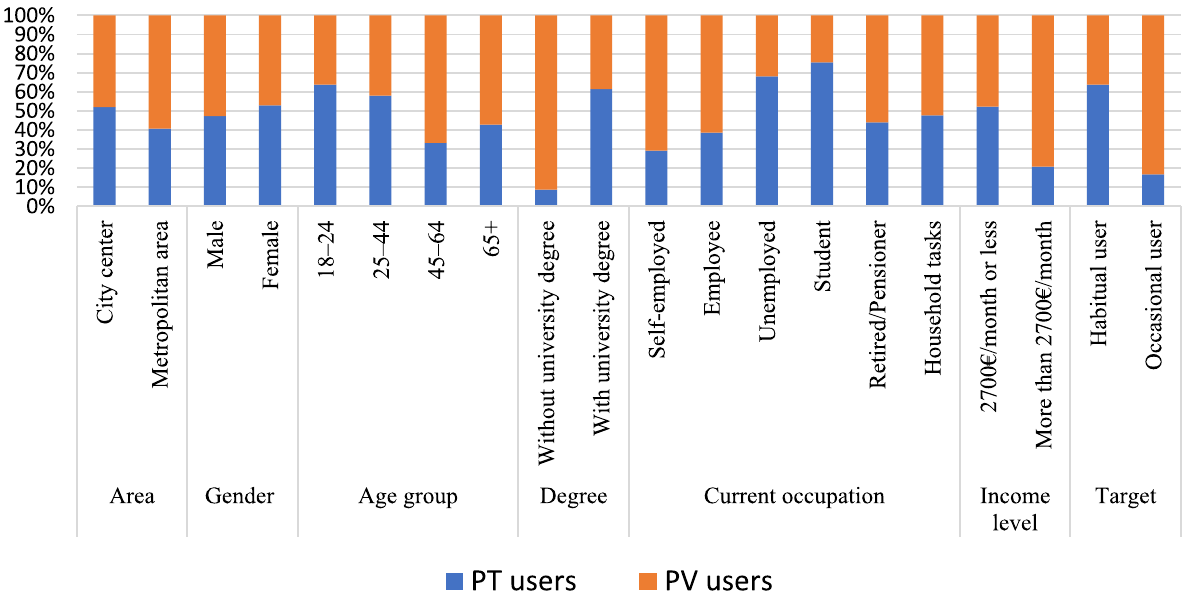
Fig. 1 The socio‑demographic characteristics of the PV and PT